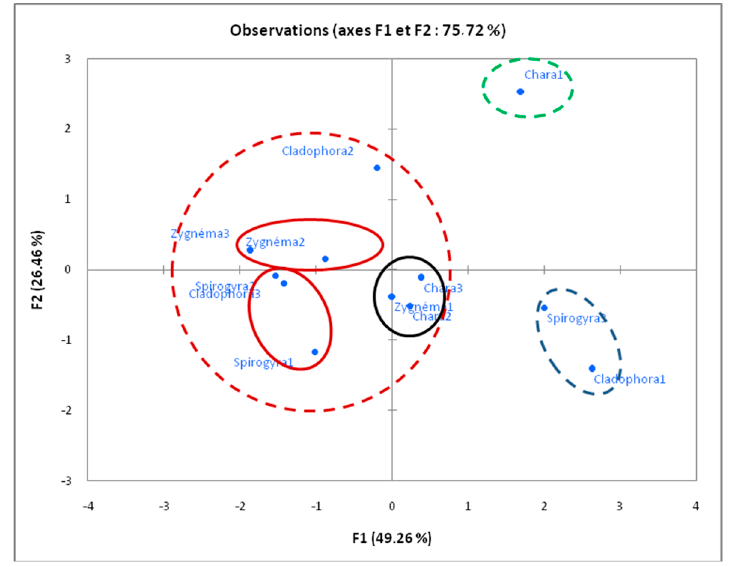
Figure 8. F1xF2 factorial design of individuals (samples).